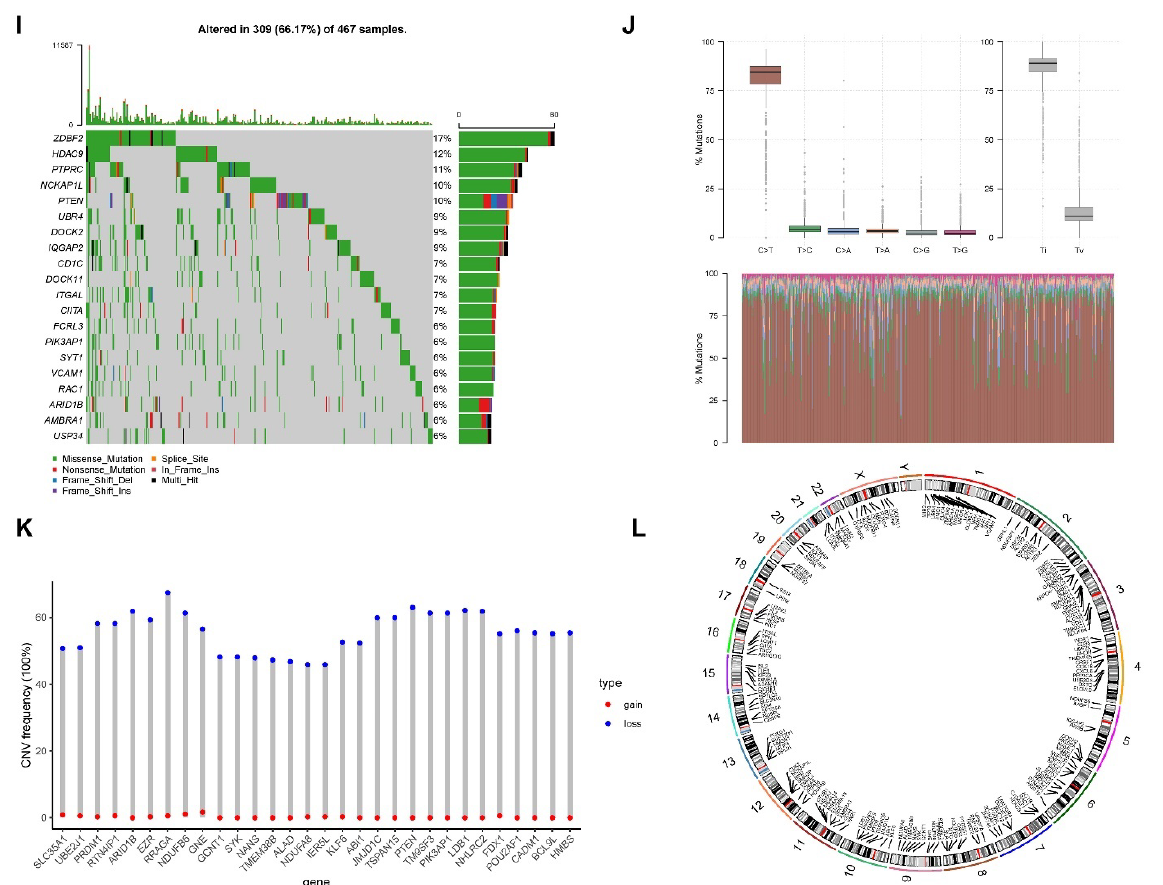
Figure 3. Transcriptional and genetic alterations of phagocytosis regulators in tumors. ( A – H ) Differential expression of phagocytosis regulatory factors in cancer samples across clinical factors, including age (41 genes were differentially expressed), gender (19 genes were differentially expressed), pathologic M (6 genes were differentially expressed), pathologic N (25 genes were differentially expressed), pathologic T (109 genes were differentially expressed), tumor stage (104 genes were differentially expressed), Breslow depth (131 genes were differentially expressed), Clark level (63 genes were differentially expressed). ( I – L ) Genomic alterations in phagocytosis regulators. ( I ) Mutation profile of the top 20 phagocytosis regulators. Our results showed that mutations occurred in 309 of the 467 samples, accounting for 66.17% of the samples. ( J ) Sample mutation frequency in 467 skin cutaneous melanoma samples. ( K ) Copy number change frequency statistics of the top 30 phagocytosis regulators. Our results demonstrated that the highest frequency of deletion occurred in RRAGA. ( L ) The positions of all phagocytosis regulators on each chromosome. The connector (small line segment connecting gene names) marks the gene’s location on the chromosome. Connectors that are more dense indicate a higher level of enrichment. We infer that the regions on chromosomes 1 and 3 are more enriched than other chromosome